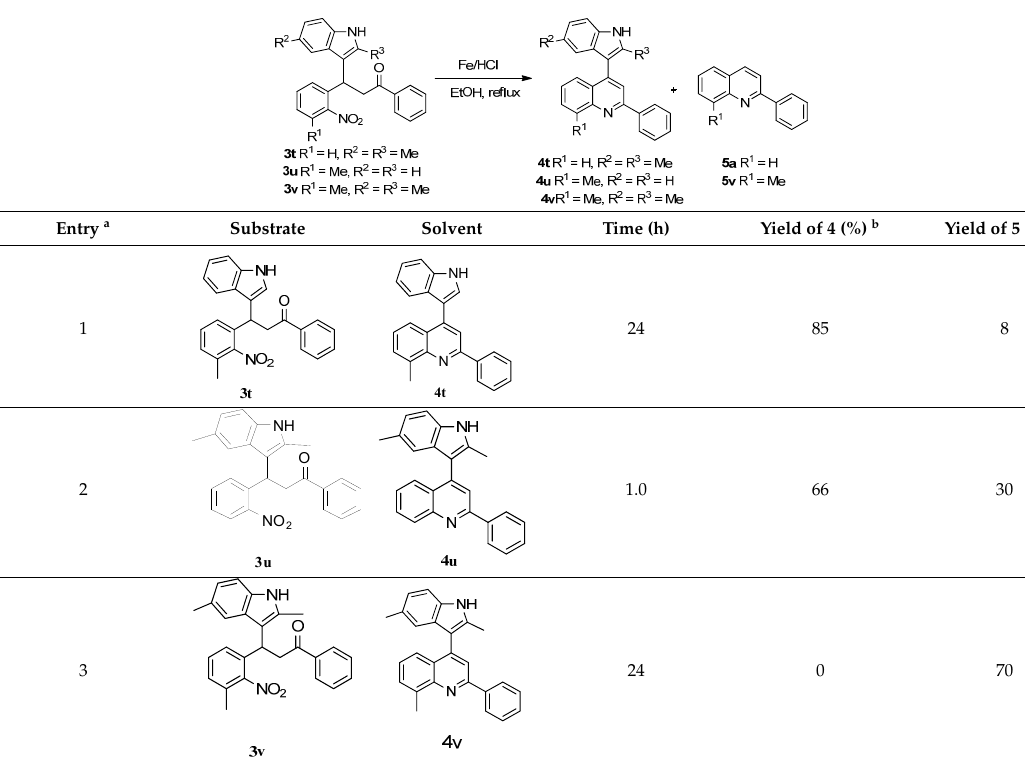
Table 6. Reductive cyclization of sterically hindered 3-(1 H -indol-3-yl)-3-(2-nitrophenyl)-1-phenylpropan- 1-one derivatives.